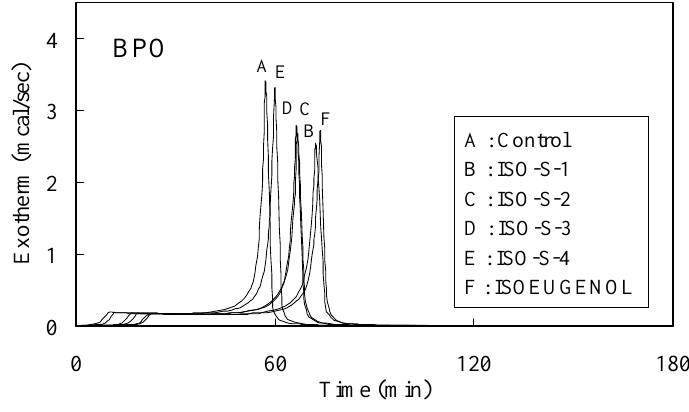
Figure 1 . Exothermic curves for the polymerization of MMA initiated by thermal decomposition of BPO in the presence of 0.01 mol% additives.